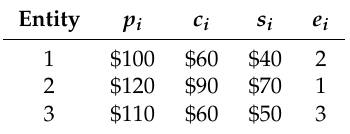
Table 2. Parameters for the three entities considered.